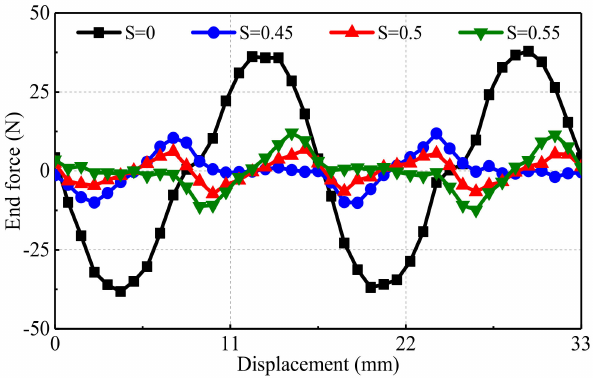
Figure 6. End forces of the DSPMLSM with different shifted